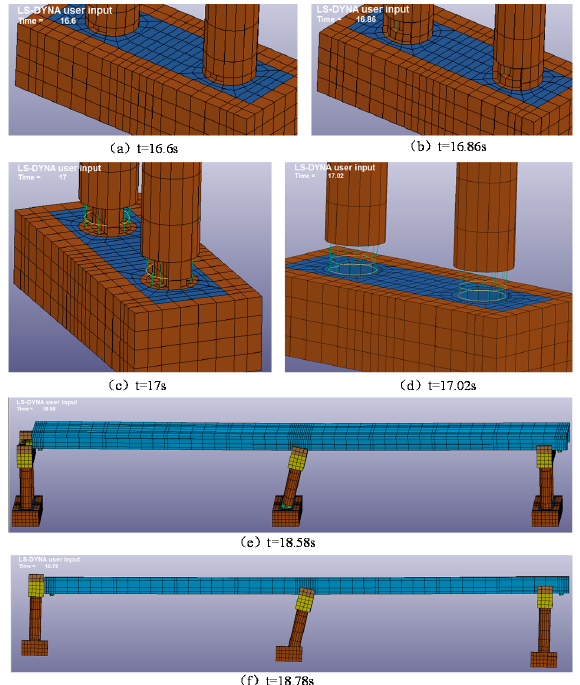
Figure 27. Longitudinal collapse mode of the CLUC system under the Chi-chi wave.